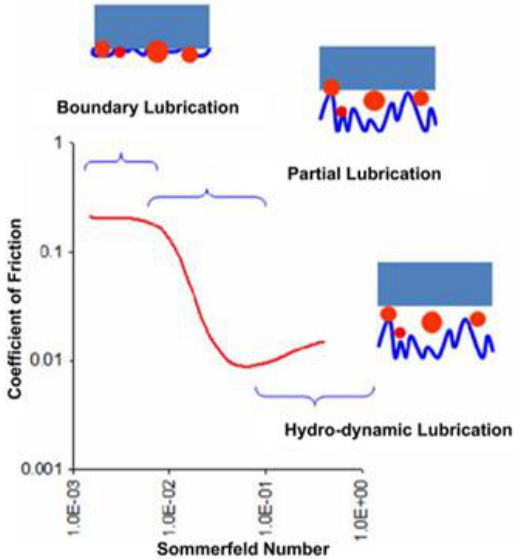
Figure 2. Stribeck curve of the CMP process [38].